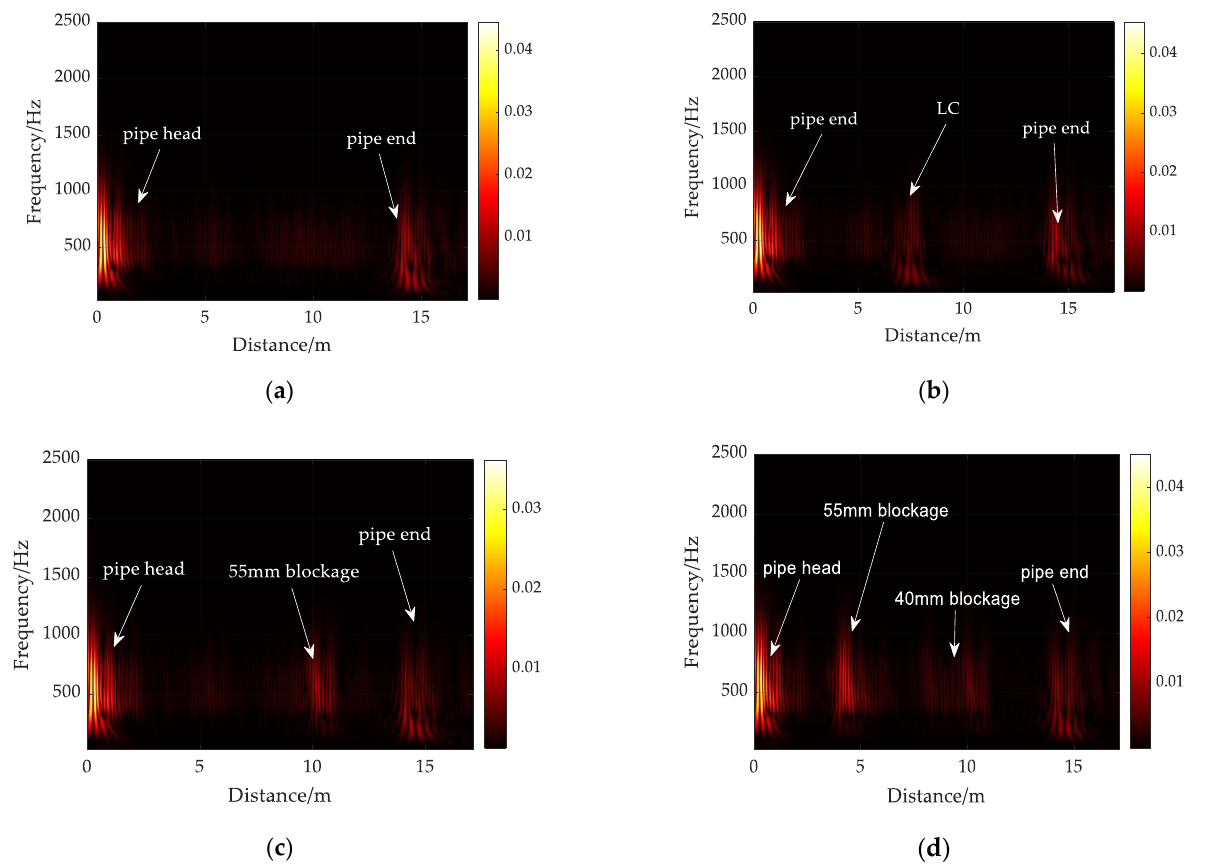
Figure 4. Time-frequency map: ( a ) clean; ( b ) lateral connection; ( c ) 55 mm blockage; ( d ) 55 mm + 40 mm blockage.